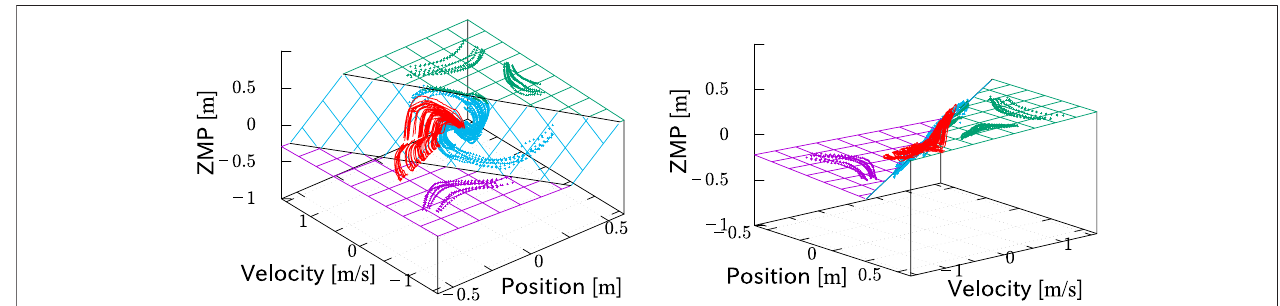
FIGURE 9 | Trajectories of standing motions (cyan, green and purple) in x - _ x - x Z space from two different viewpoints. Hatched planes in cyan, green and purple represent identi fi ed subspaces (S1), (S2) and (S3), respectively. Trajectories of step-and-brake motions (red) are superposed on it. The asymptotic plane of the latter trajectories coincides with the segmented plane of the convergent motions of the standing (hatched in cyan).